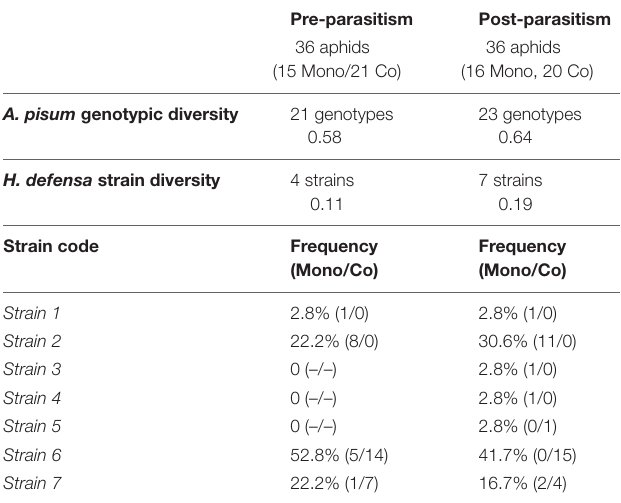
TABLE 2 | Aphid clonal diversity, H. defensa strain diversity and haplotypes in the “pre-parasitism” and “post-parasitism” periods for pea aphids collected in alfalfa